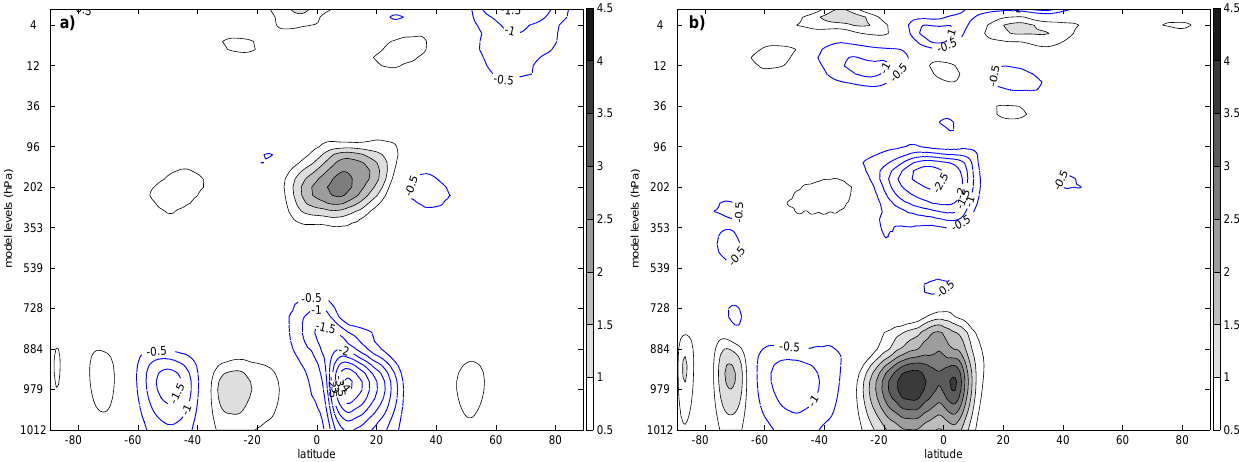
Figure 10. As in Fig. 9 but for the IG component of the zonally averaged meridional wind: (a) January and (b) July. Contour interval is 0.5 m/s.